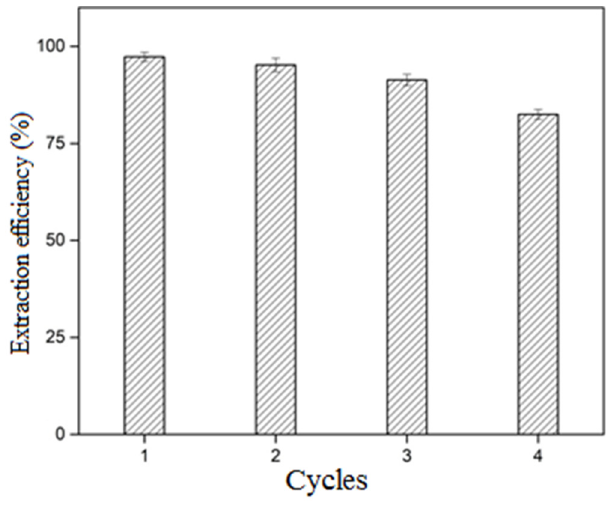
Figure 10. Extraction efficiency of poly[veim][Tf 2 N] − TRIM towards MB at 500 mg/L initial concen- tration in different cycles.